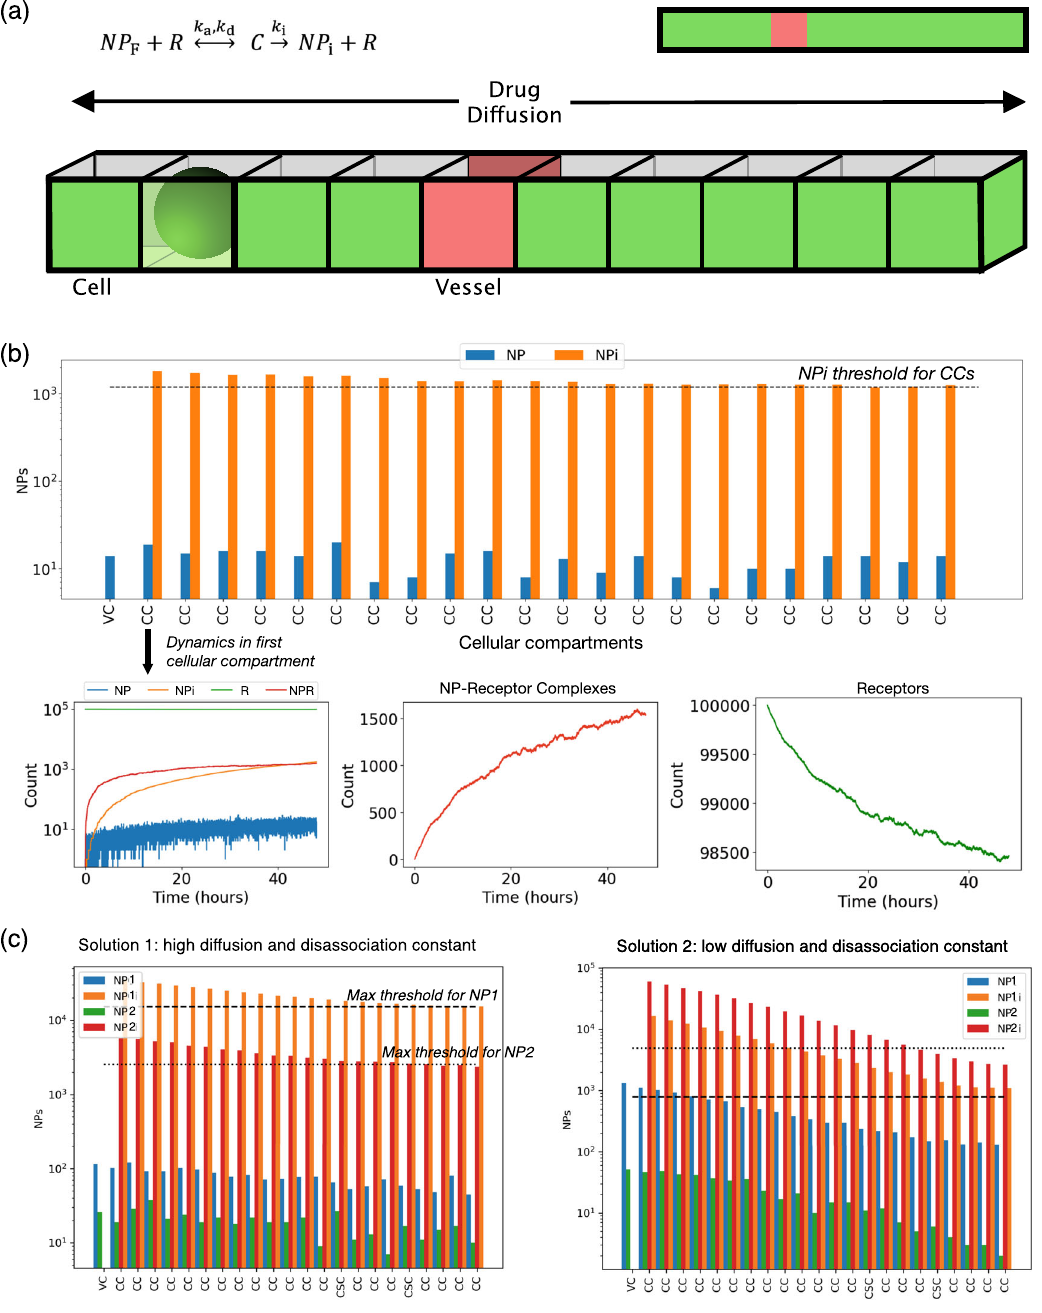
Fig. 3 Virtual tissue module of the EVONANO platform. We use STEPS to solve the stochastic reaction network, shown in ( a ), for nanoparticles that diffuse from vessel points (shown in red) into well-mixed compartments (shown as green cubes) representing tumour cells (shown as a green sphere). In ( b ), we show the total penetration pro fi le of nanoparticles within a homogeneous tumour, such as the number of nanoparticles (NP) and internalised nanoparticles (NP i ) within each cellular compartment. Here the nanoparticle and treatment parameters are able to successfully penetrate and kill all cancer cells. Each cell contains example Cell – nanoparticle dynamics such as increased number of nanoparticle – receptor complexes (NPR), and a decrease in overall receptors over time. We also show, in ( c ) the two optimum solutions of a heterogeneous cell